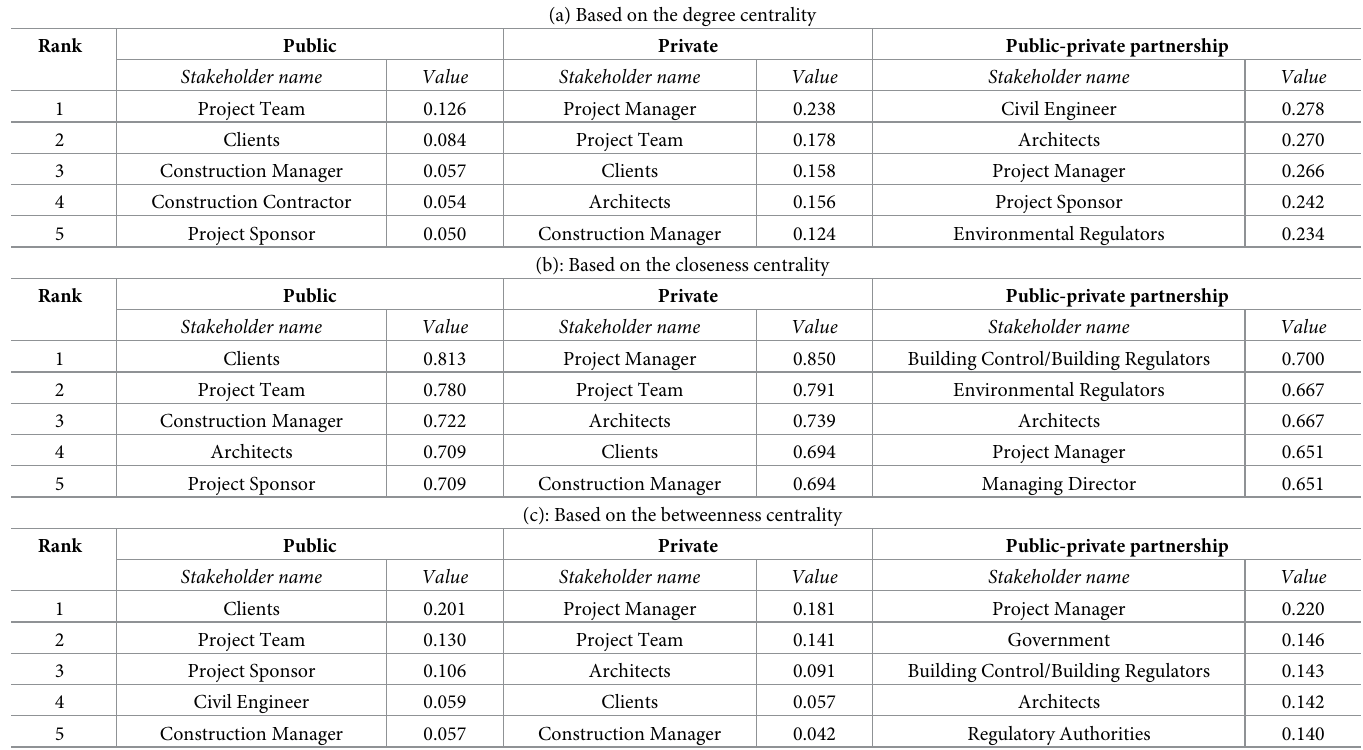
Table 5. Top-5 nodes or stakeholders in the three different aggregated networks.